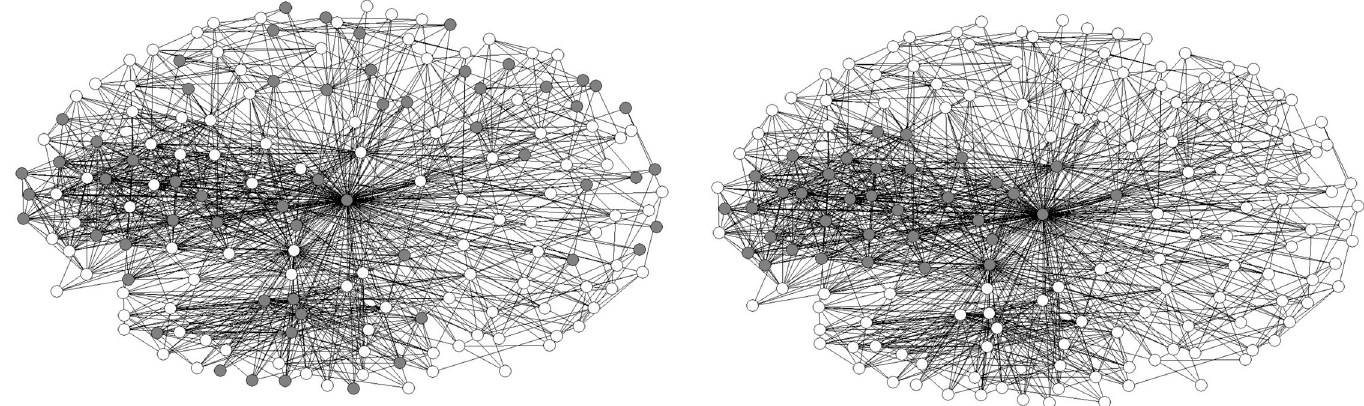
Fig 17. Identification of central and marginal members of the ADS migrant workers’ network using different methods. (a) uses the number of friends or acquaintances in the individual-level questionnaire; (b) uses the core-periphery model. The dark nodes are central members, while the white nodes are marginal